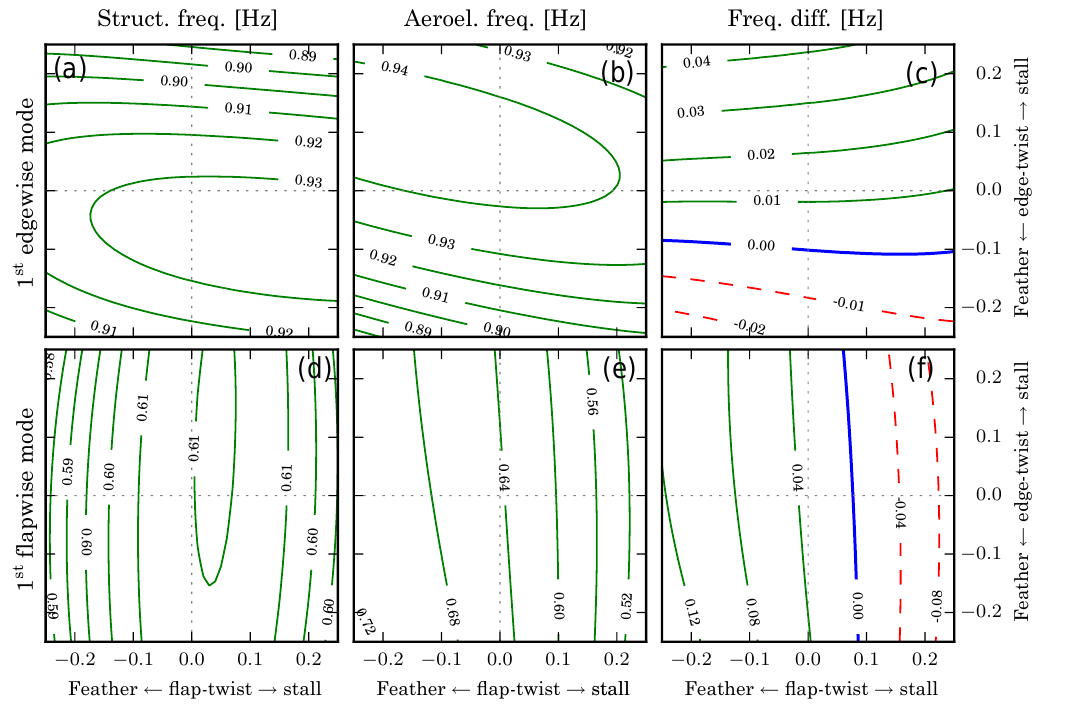
Figure 7. Contour plots of structural (left) and aeroelastic (middle) frequencies and their difference (right) of the first edgewise (top) and first flapwise (bottom) mode for varying edge–twist (ordinate) and flap–twist (abscissa) coupling coefficients at 8ms − 1 wind speed. Struct. damp. ratio [%]